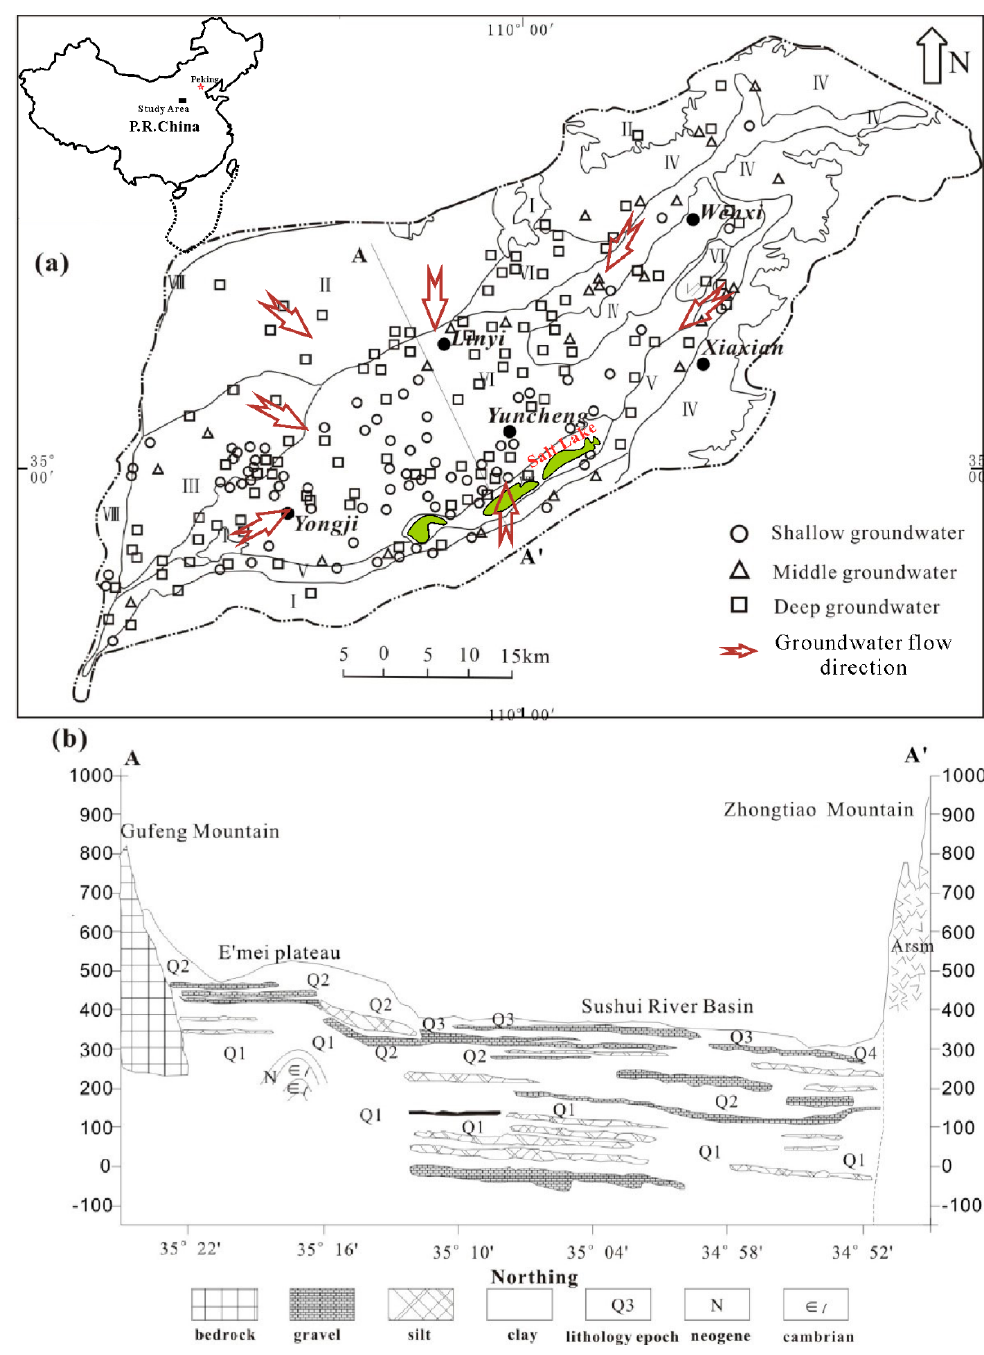
Figure 1. (a) Sampling locations at Yuncheng Basin, Shanxi Province, China. I, the Berock Mountain; II, the Emei high Uplifted area; III, the Kaolao low Uplifted area; IV, the loess hilly region; V, Piedmont plain; VI, Alluvial plain; VII, Fluvial depressions; and VIII, the Yellow River Terrace. (b) Schematic cross-section of the basin. Q 1 –Q 4 represent quaternary sediments. Modified from Reference [5].